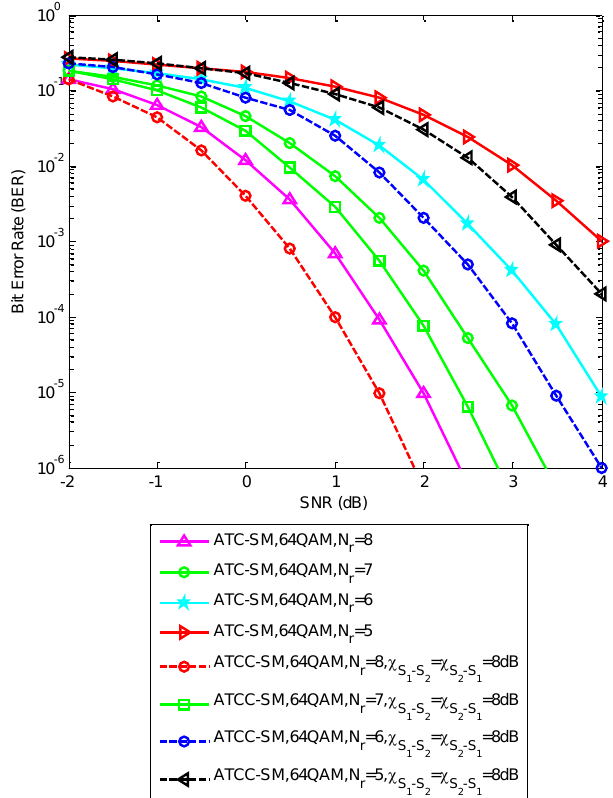
Figure 11. BER performance of the two-source ATCC-SM scheme under a non-ideal inter-user channel scenario and ATC-SM based on the CMI over the slow Rayleigh fading channel, K = 1024, 64QAM, N t = 8 and different numbers of receive antennas.